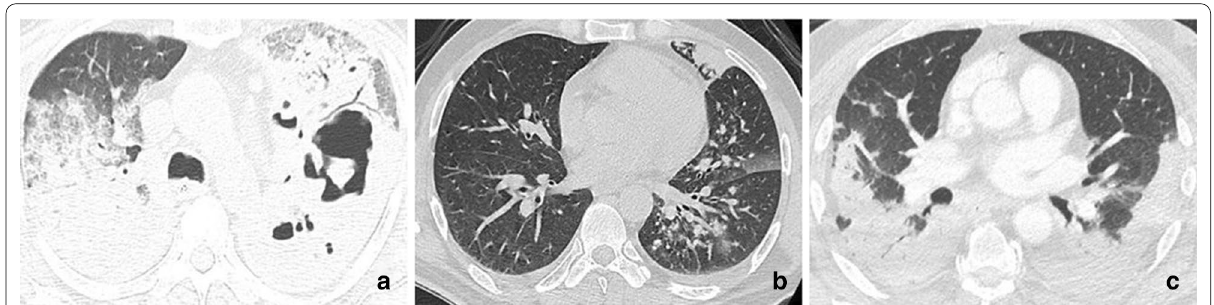
Fig. 13 Atypical features for COVID‑19. a A 47‑year‑old man with respiratory syncytial virus (RSV) pneumonia, axial HRCT image shows left pulmonary tree‑in‑bud opacities with centrilobular nodules, nearby patches of GGO and segmental consolidation anteriorly. b A 58‑year‑old woman with methicillin‑resistant staphylococcus aureus (MRSA) pneumonia, HRCT shows bilateral consolidation with areas of GGO superimposed with crazy paving and cavitation on the left side. c A 67‑year‑old woman admitted to ICU with positive RT‑PCR for COVID‑19, axial HRCT